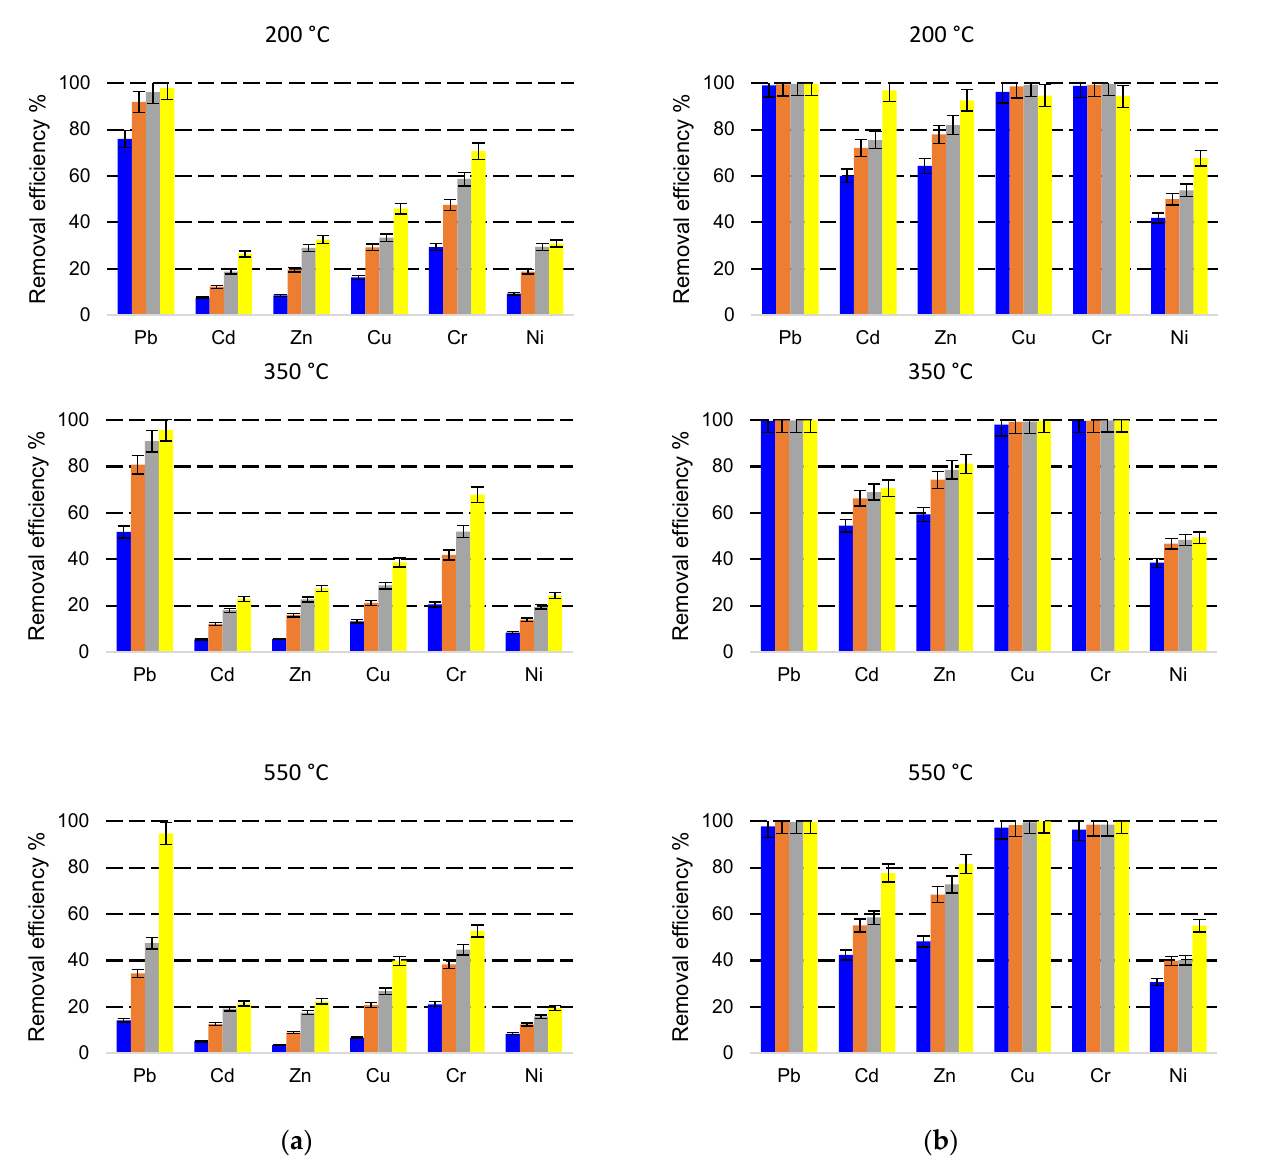
Figure 3. Simultaneous removal of Pb, Cd, Zn, Cu, Cr, Ni with NZ1 ( a ) and NZ2 ( b ) thermally treated at 200 °C, 350 °C, and 550 °C from a multicomponent solution of 10 mg L − 1 at four different contact times (5 min—blue, 10 min—orange, 30 min—grey, 60 min—yellow).